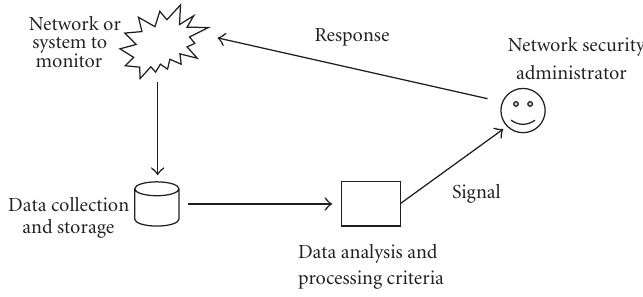
Figure 1: Architecture of